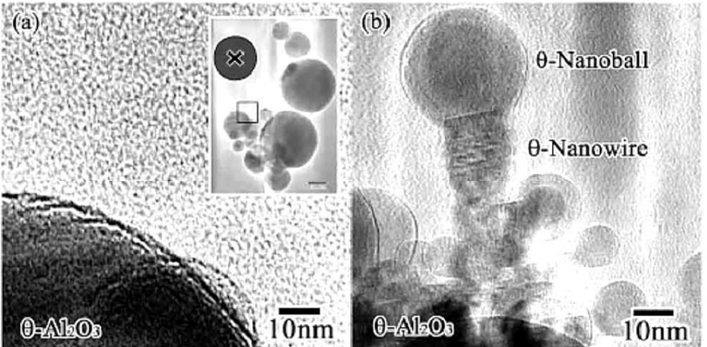
Figure 17. θ -Al 2 O 3 nanowire and nanoball grown under flashing mode electron beam irradiation (i.e., rapid switching between intensities of 5.5 × 10 22 and 5 × 10 19 e/cm 2 s). They connected and grew toward the irradiation centre from the original θ -Al 2 O 3 particle surface. The nanowire grew epitaxially maintaining the same plane as the parent θ -Al 2 O 3 particle. ( a ) θ -Al 2 O 3 particles before irradiation, with X indicating the irradiation centre. ( b ) θ -Al 2 O 3 nanowire and nanoball grown after electron beam irradiation [13].